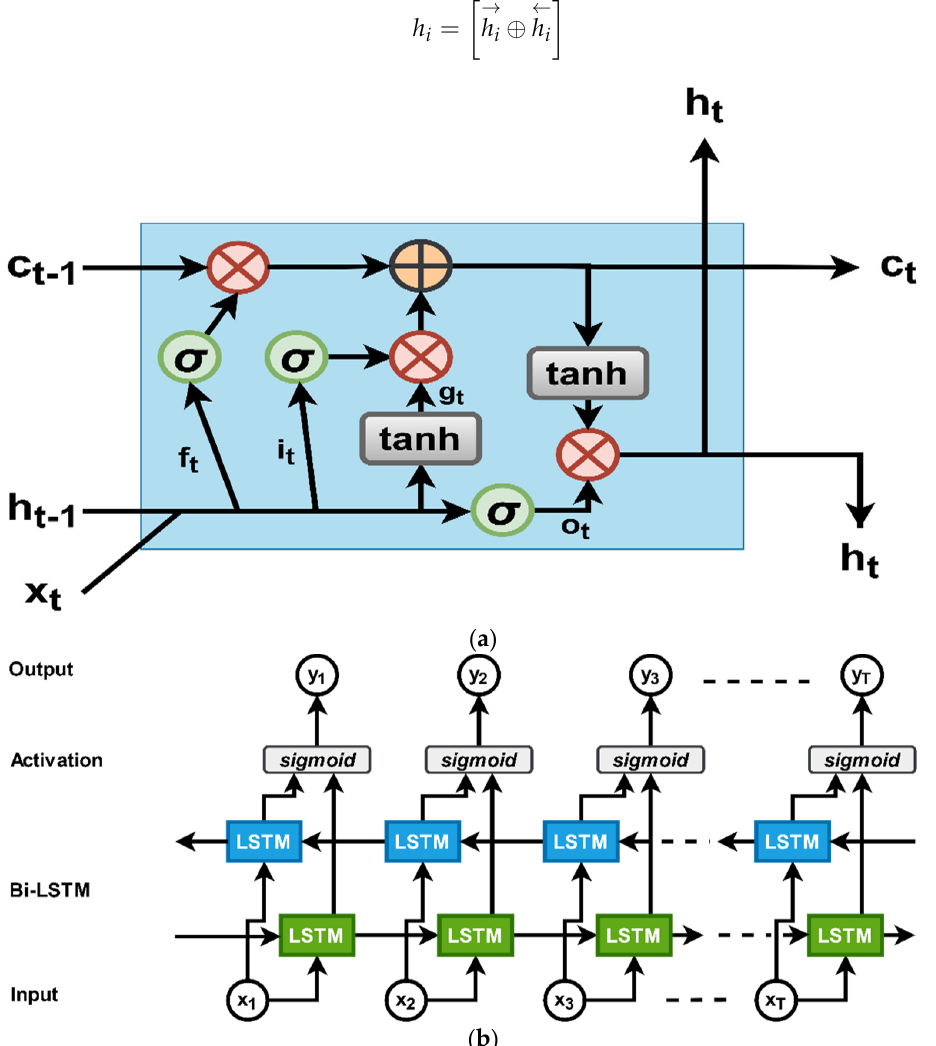
Figure 2. An illustration of LSTM and a bi-directional LSTM model. In our proposed model, we have used bi-LSTM as an encoder and sequential LSTM as a decoder. ( a ) The illustration of an LSTM diagram. Here, the forget gate, input gate, and output gate denote as f t , i t , and o t , respectively. ( b ) The illustration of a bi-LSTM model. Two layers, such as the forward pass and backward pass LSTM, followed by the sigmoid